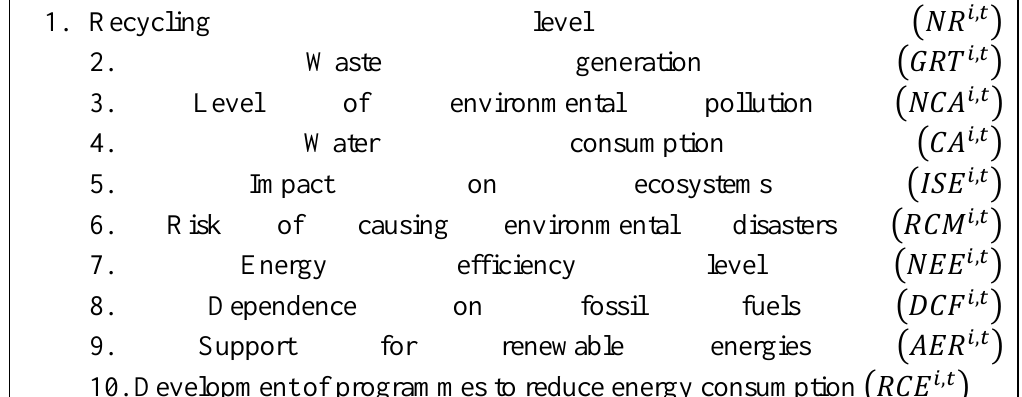
Table 1: Environmental Variables 1.